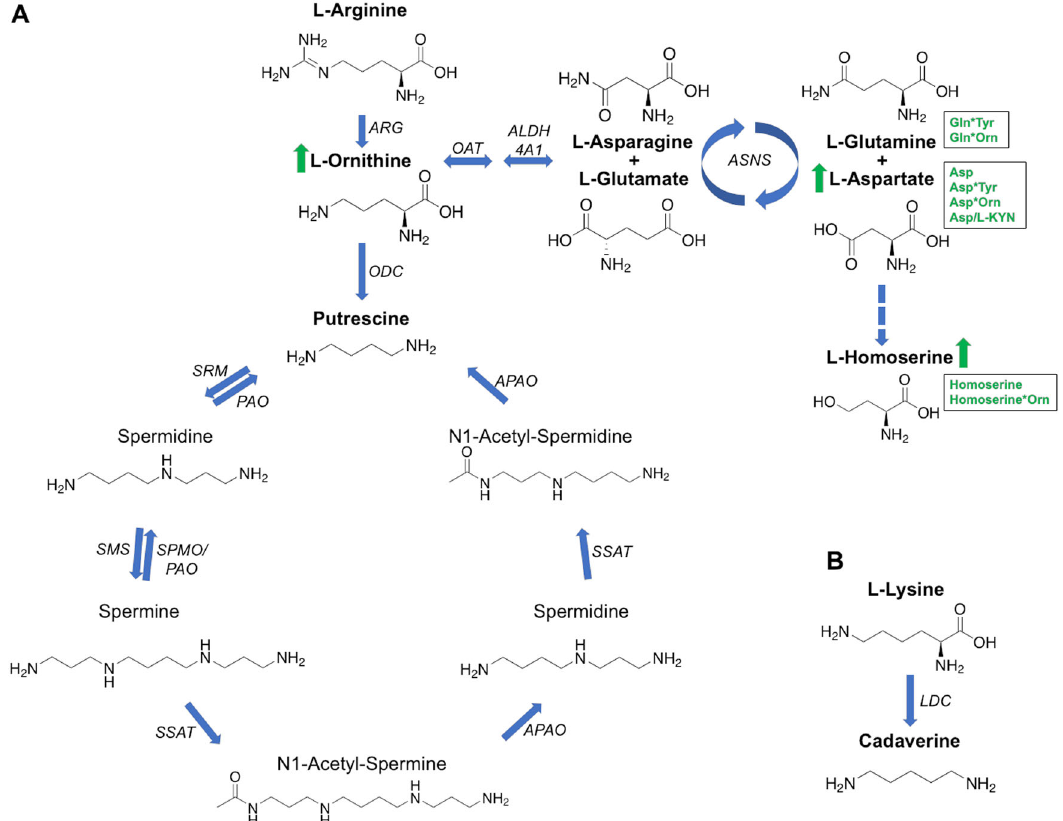
Fig. 2 Polyamine pathway and Cadaverine pathway. A Polyamine pathway and B Cadaverine pathway. The metabolites highlighted in bold have been targeted and detected in this study. L -Ornithine, L -Glutamine and L -Aspartate are all signi fi cantly increased in the iPD cohort (arrows and text written in green). ARG arginase, ODC ornithine decarboxylase, SRM spermidine synthase, PAO polyamine oxidases, SMS spermine synthase, SPMO spermidine oxidase, SSAT1 and 2 diamine acetyltransferase 1 and 2, APAO acetylated polyamine oxidase, LDC lysine decarboxylase, OAT ornithine aminotransferase, ALDH4A1 delta-1-pyrroline-5-carboxylate dehydrogenase), ASNS asparagine synthetase